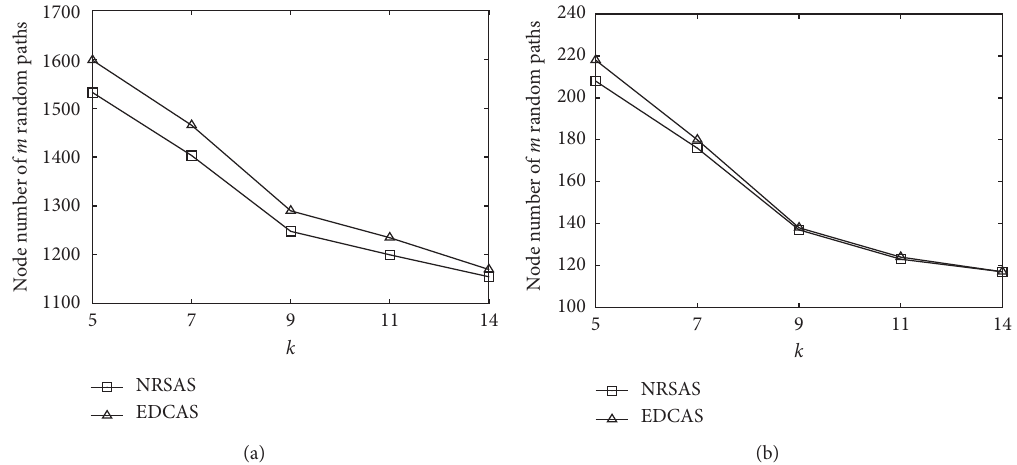
Figure 13: The effect of the sparsity on the random path. (a) Synthetic dataset. (b) IntelLab